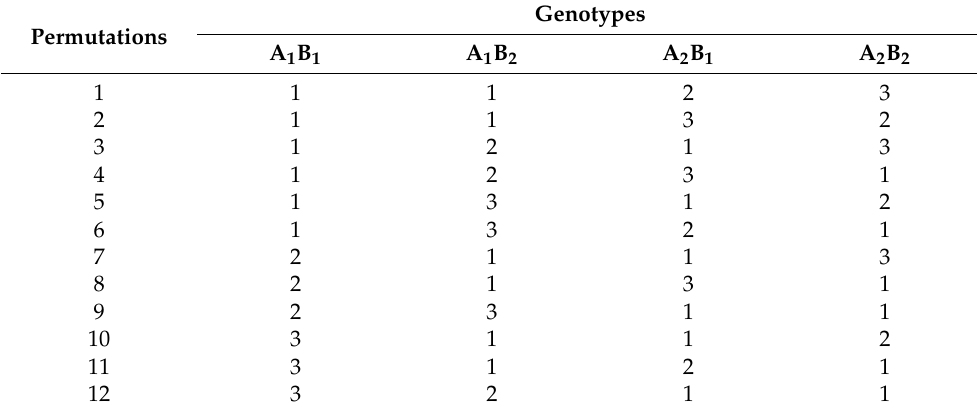
Table 3. Different permutations of the frequencies of SF k = (3): 1, 1, 2, 3 of the genotypes that can be produced by the single-cross A 1 A 2 × B 1 B 2 when the progeny consists of 7 plants ( m = 7). Permutations